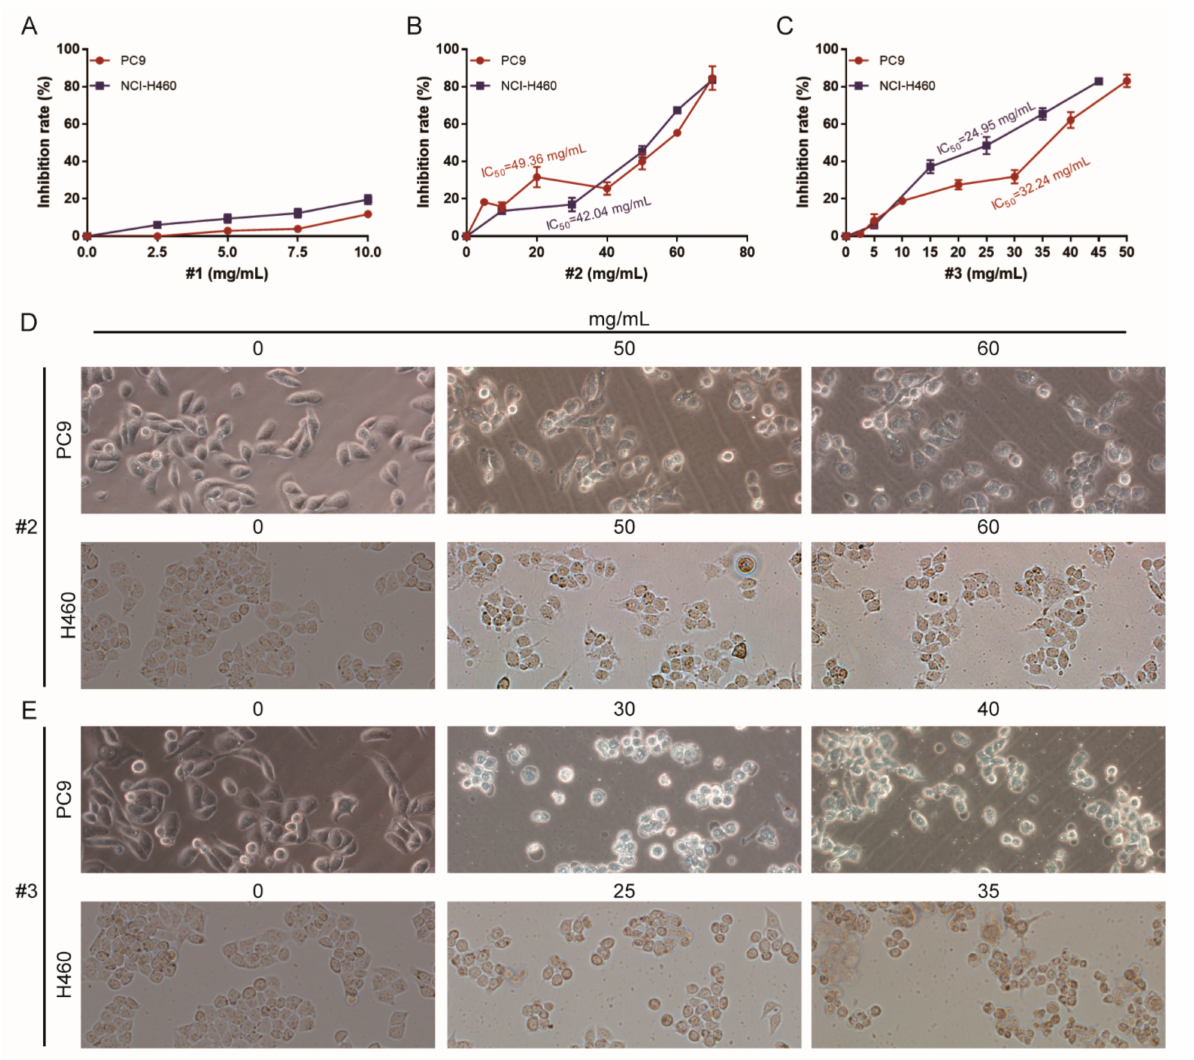
Figure 2. MTT analysis ( A – C ) and morphological observation ( D , E ) of different fractions of F. luteovirens on PC9 and NCI-H460 cells at different concentrations. The MTT results are expressed as the mean ± SD of three independent